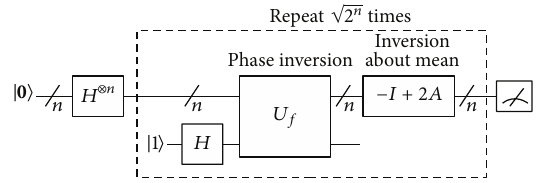
Figure 4: Modelling of Grover’s search based on quantum circuit model